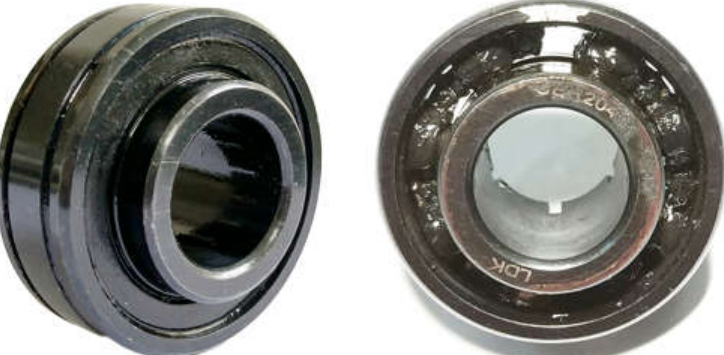
Figure 7. Bearings in two different states.